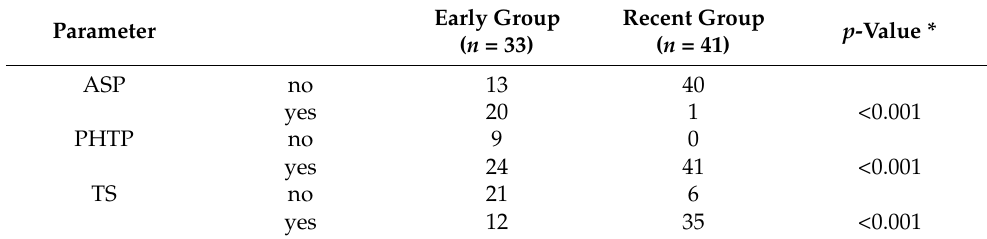
Table 2. Qualitative brace changes.